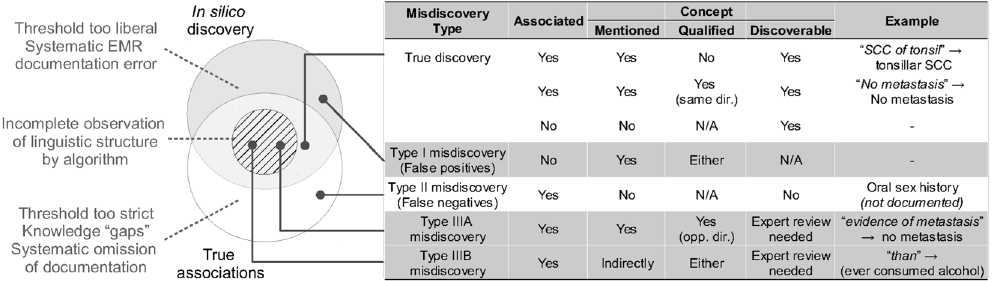
Figure 5. Scenarios, examples, and potential sources of